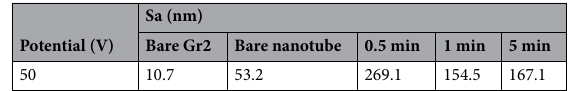
Table 2. Average roughness (Sa) of the